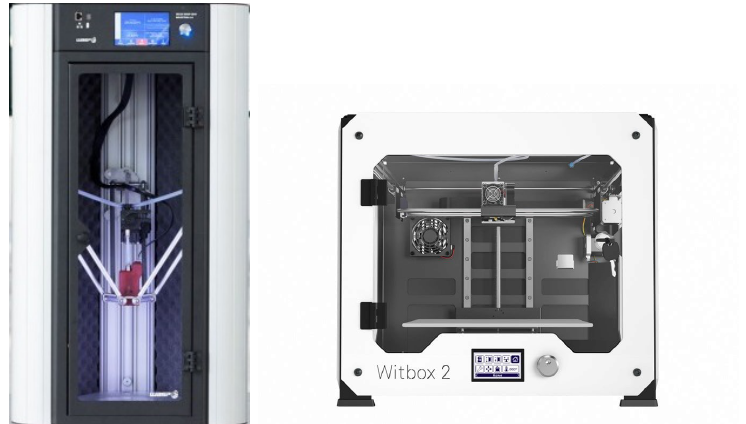
Figure 1. The used 3D printers, the delta WASP 4070 Industrial by Wasp and the portal Witbox by bq